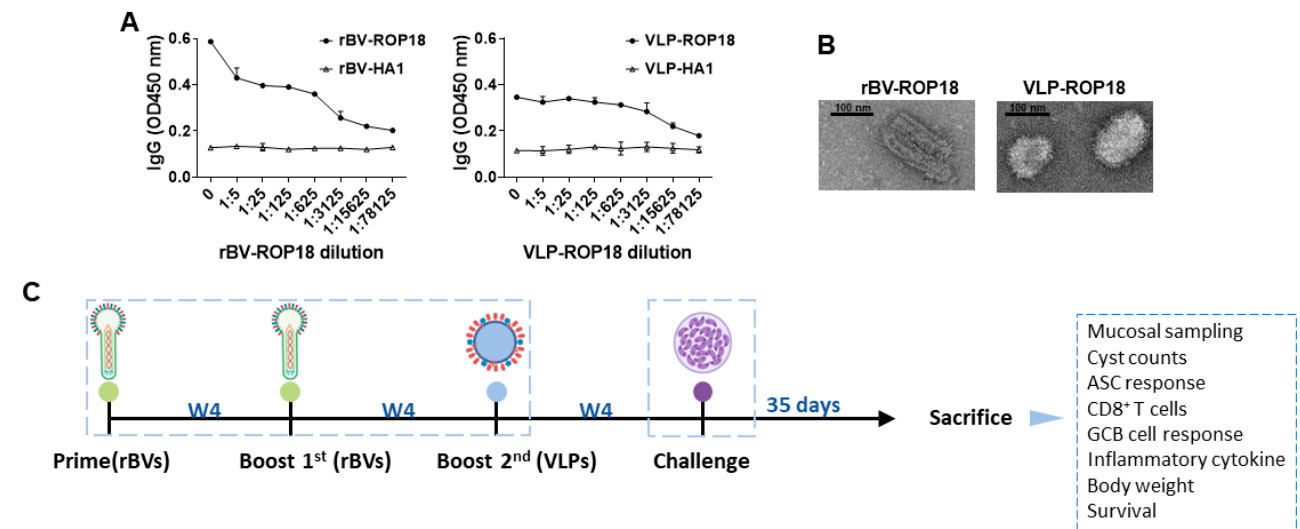
Figure 1. Characterization of rBVs and VLPs, and immunization schematic. Polyclonal T. gondii antibody was used to assess ROP18 proteins in rBVs and VLPs via ELISA ( A ). rBVs-ROP18 and VLPs-ROP18 were observed under a transmission electron microscope (TEM) ( B ). BALB/c mice were primed-boosted with rBVs-ROP18 and subsequently 2nd boosted with VLPs-ROP18 via oral, IN, and IM routes at regular intervals ( C ). All immunization, infection, sample collection schedules, immunological assay, and bodyweight with survival conducted were exactly followed as depicted above.